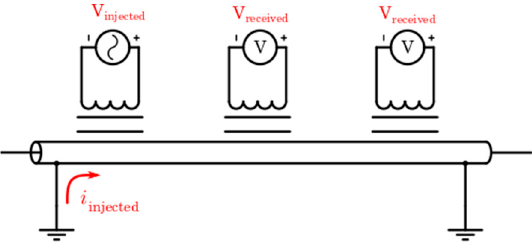
Figure 3. PLC through the sheath and the earth in primary distribution line cables.